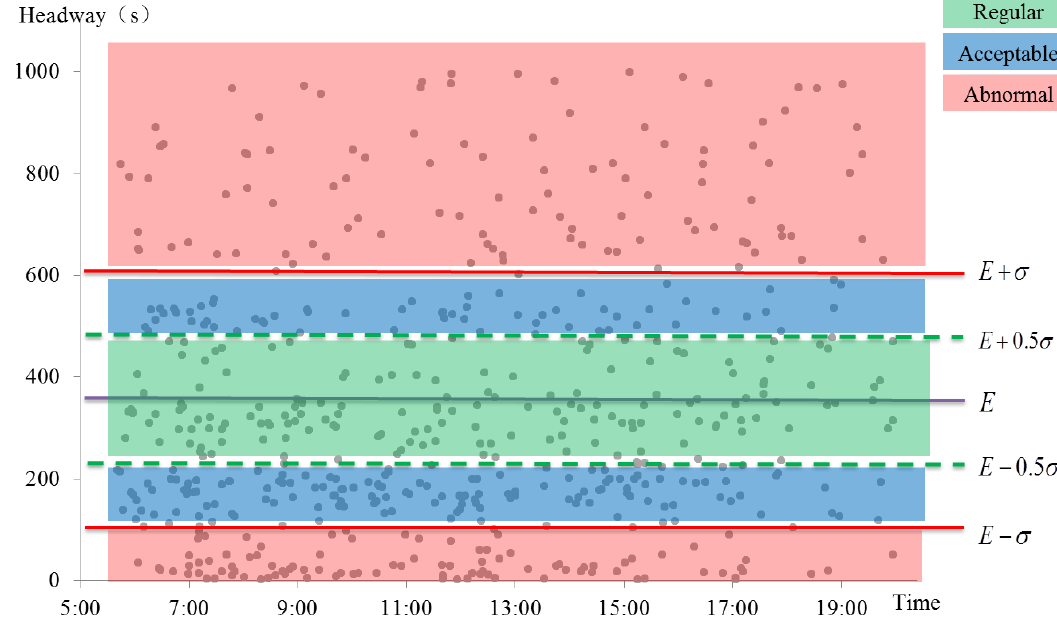
Figure 3. Abnormal headway identification on stop No.15 of Route